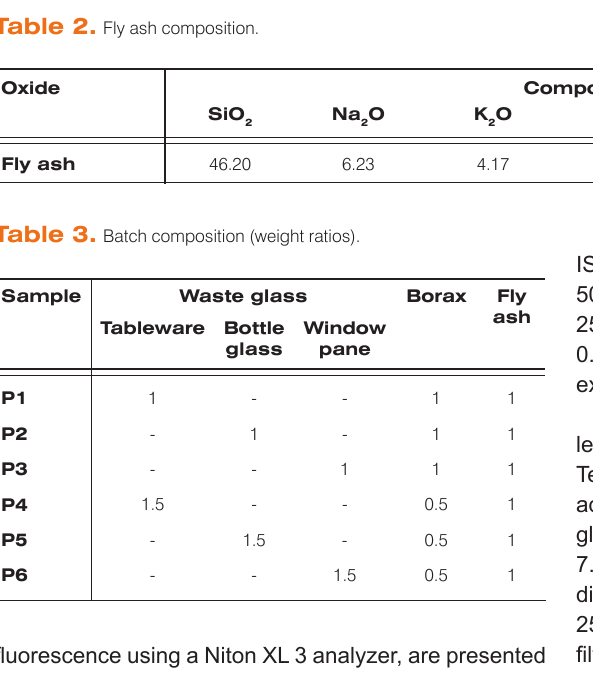
Table 2. Fly ash composition.